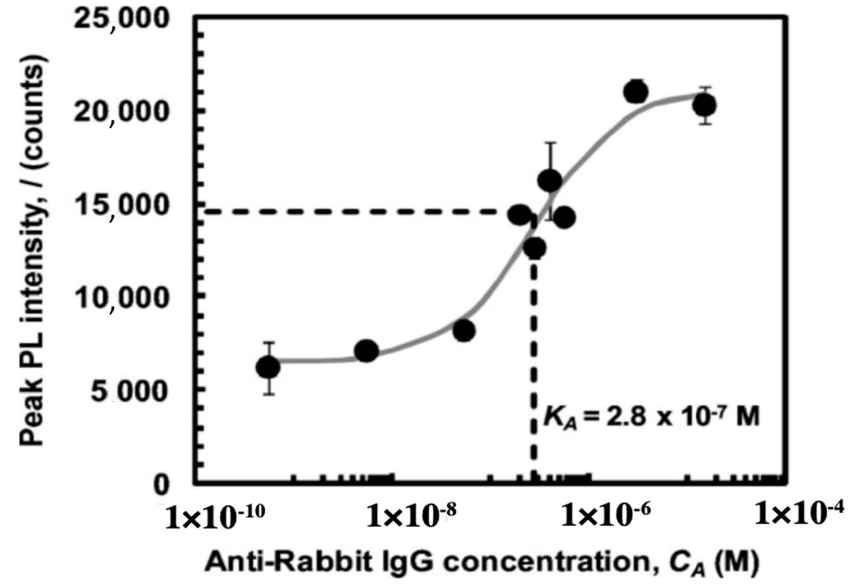
Figure 8. Dose-response curve of the label-free photoluminescence-based biosensor described in reference [100]. Binding constant is also reported. Reproduced with